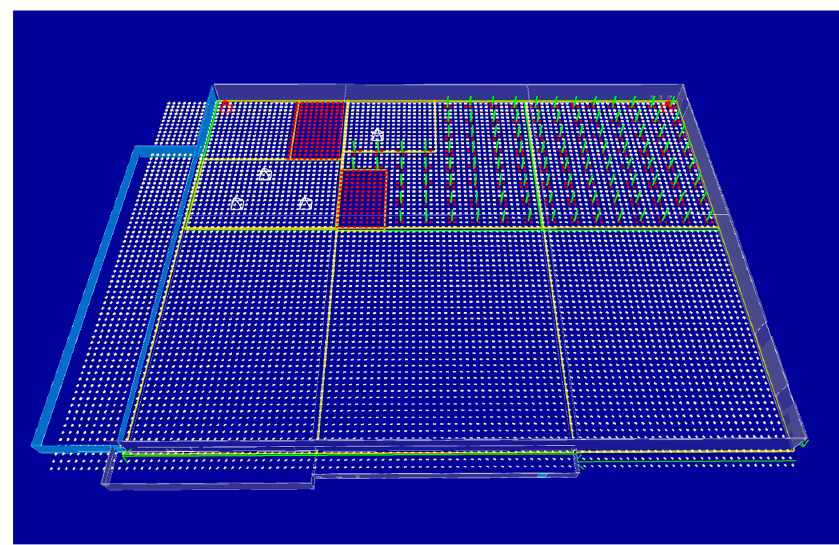
Figure 12. Scenario 1 navigation grid with accessible and inaccessible nodes. Appl. Sci. 2019 , 9 , x FOR PEER REVIEW